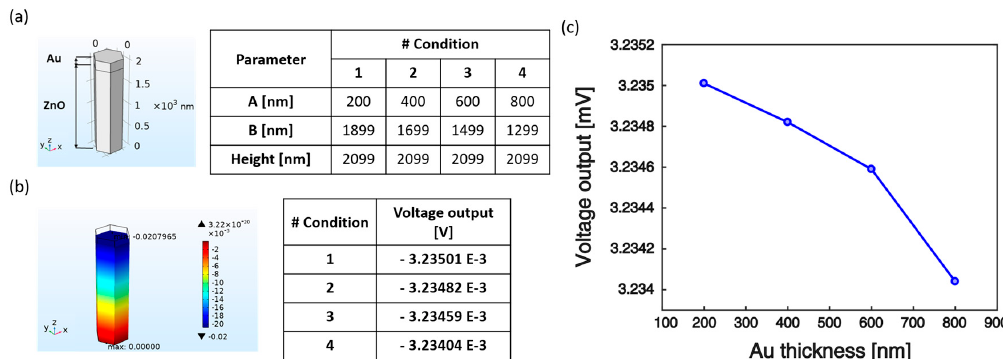
Figure 11. Effect of top electrode thickness on voltage response. ( a ) Four conditions have been tested numerically corresponding to different thicknesses of the Au top layer. ( b ) Electric potential generated under mechanical load of 14 kPa applied on top of the NR. ( c ) The voltage output was found to decrease as top electrode thickness increases.